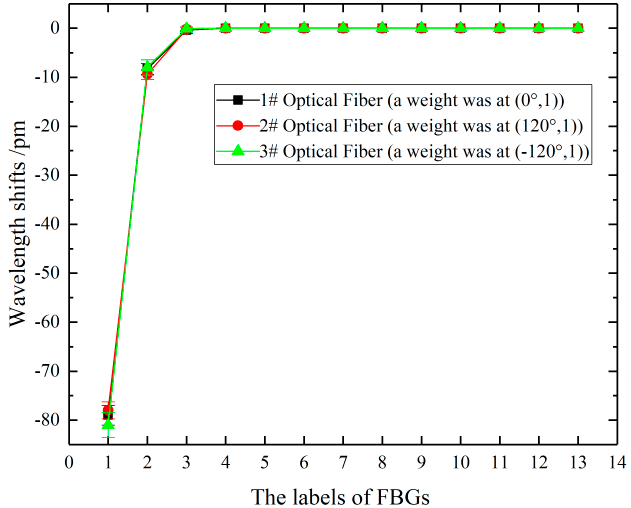
Figure 9. The wavelength shifts of FBG1n, FBG2n and FBG3n when a simulated load of 2 N was at (0°, 1), (120°, 1) and ( − 120°, 1), respectively.